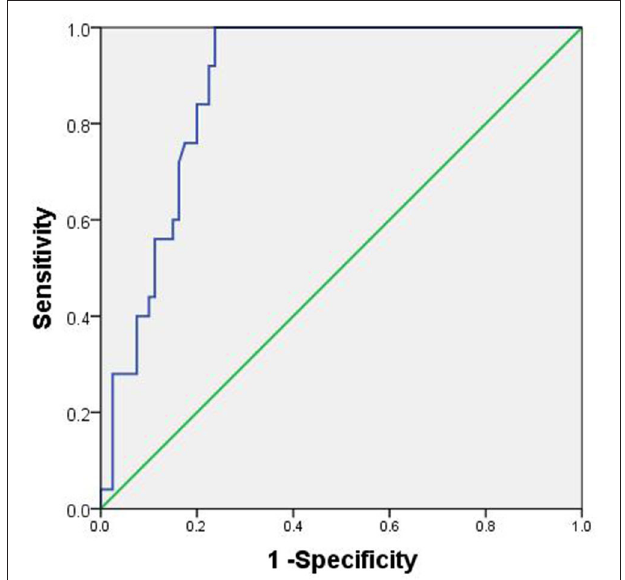
FIGURE 1 | ROC curve of CRP.